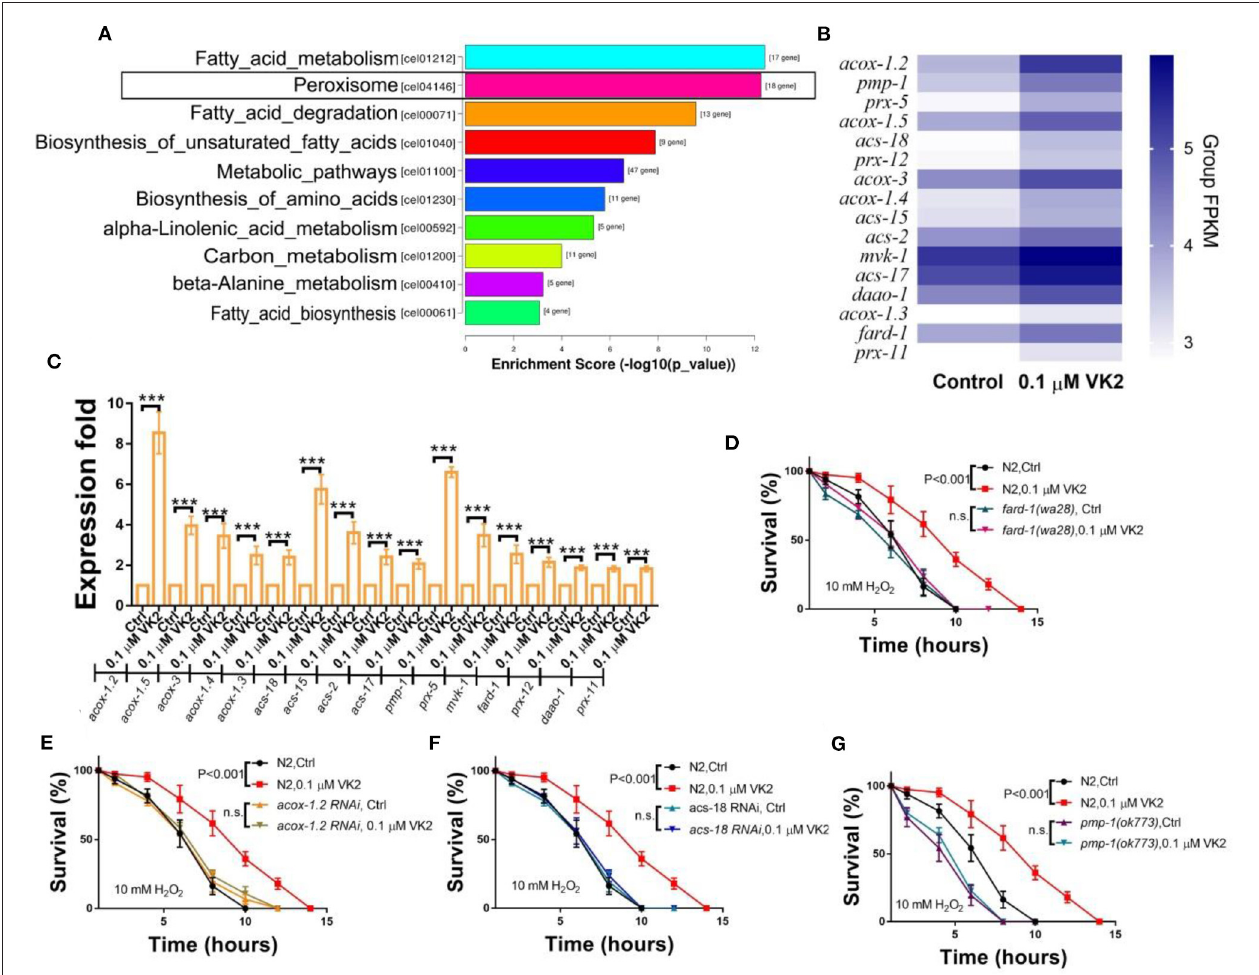
FIGURE 4 | VK2 promotes fatty acid degradation in the peroxisome. (A) The second most significantly enriched KEGG pathway among the up-regulated genes induced by VK2 was Peroxisome. There were 18 genes enriched for Peroxisome. (B) Heat-map analysis of these genes was carried out using Group FPKM based on RNA-seq data. (C) The expression levels of these 18 genes were further confirmed using real-time PCR. *** P < 0.001. acox-1.2 , acs-18 , and pmp-1 were the top three genes up-regulated by VK2 according to the real-time PCR data. The effects of VK2 on oxidant resistance were blocked by fard-1 mutants (D) , acox-1.2 RNAi (E) , acs-18 RNAi (F) , or pmp-1 mutations (G) . The treatments were repeated at least three times. The P -values were determined using a t -test. n.s., no significant